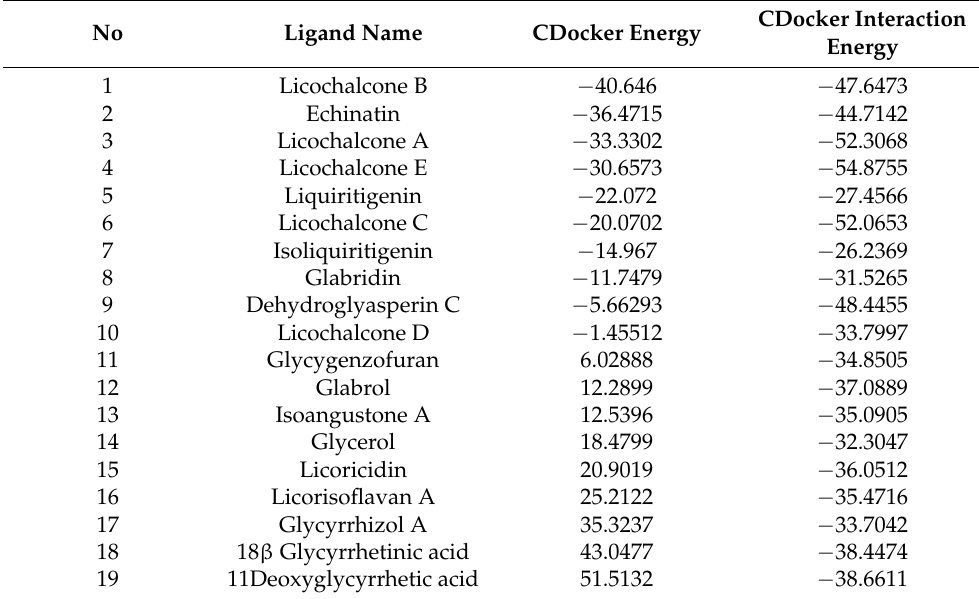
Table 2. Docking energy table of the screened flavonoids calculated by